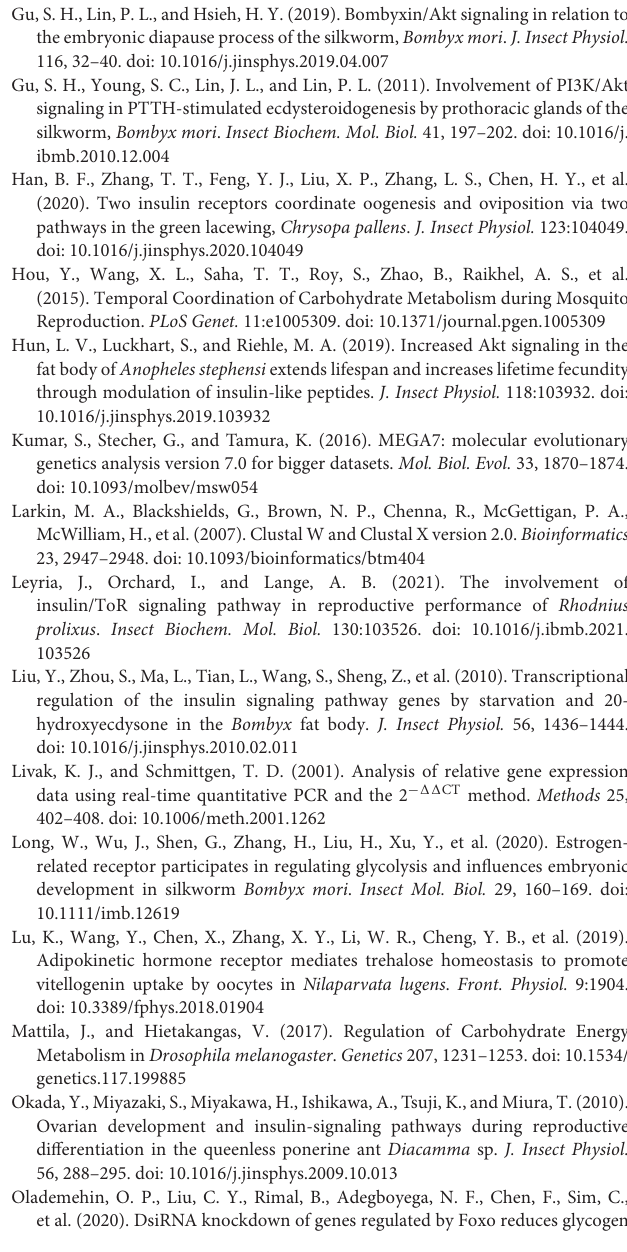
Supplementary Figure 1 | Nucleotide and deduced amino acid sequences of LsAkt cDNA. The start codon is indicated in bold and the stop codon in bold with an asterisk. The predicted phosphorylation sites, including serine (S), threonine (T), and tyrosine (Y), are marked in red, yellow, and green, respectively. The low complexity region is shaded and PH domain is underlined. The S_TKc domain is boxed and S_TK_X domain is underlined with wavy